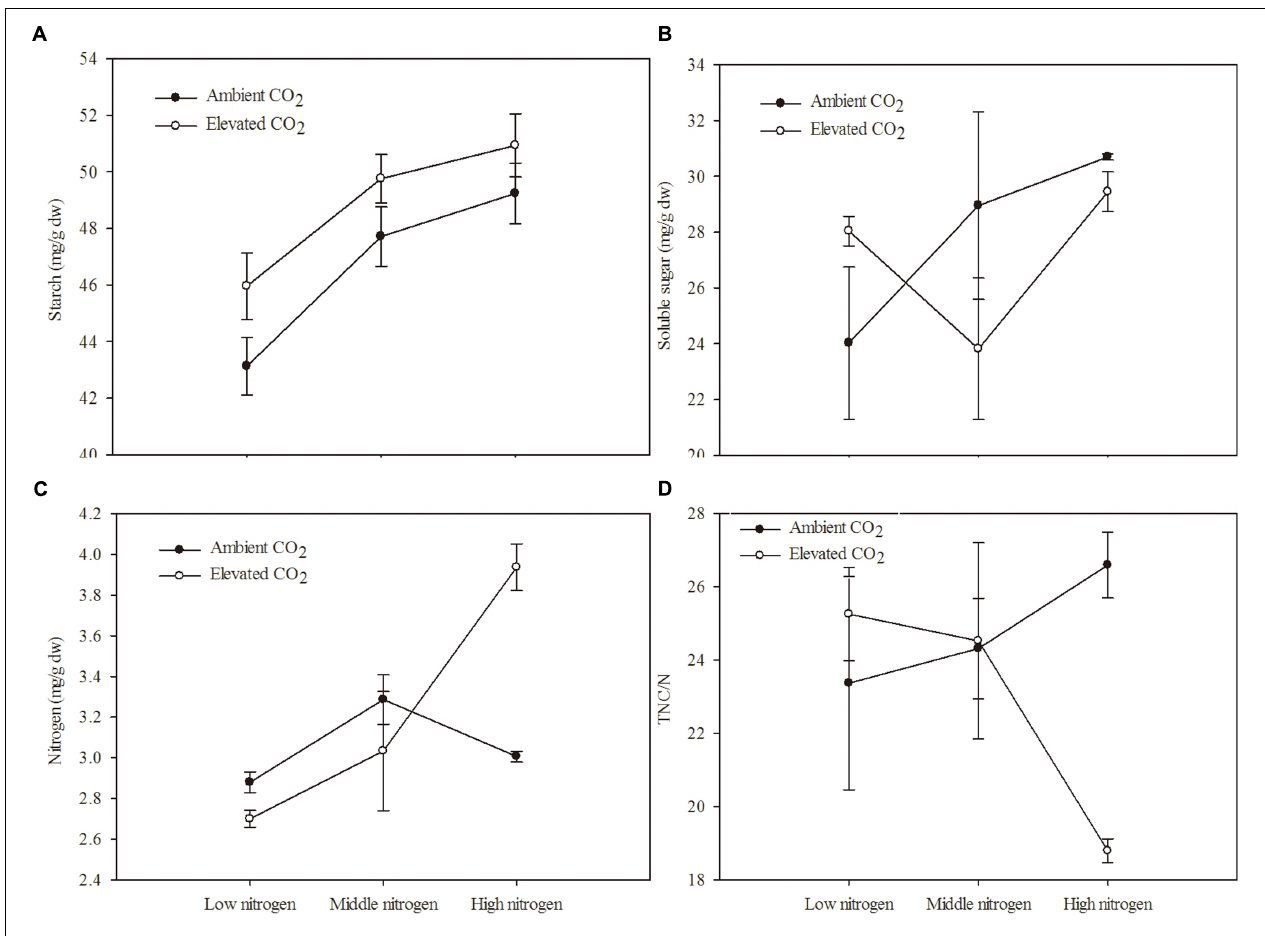
FIGURE 1 | Chemical components of maize grown under different levels of CO 2 and nitrogen fertilization conditions (mean ± SE, n = 3). (A) Starch, (B) soluble sugar, (C) nitrogen (N), and (D) total non-structural carbohydrates